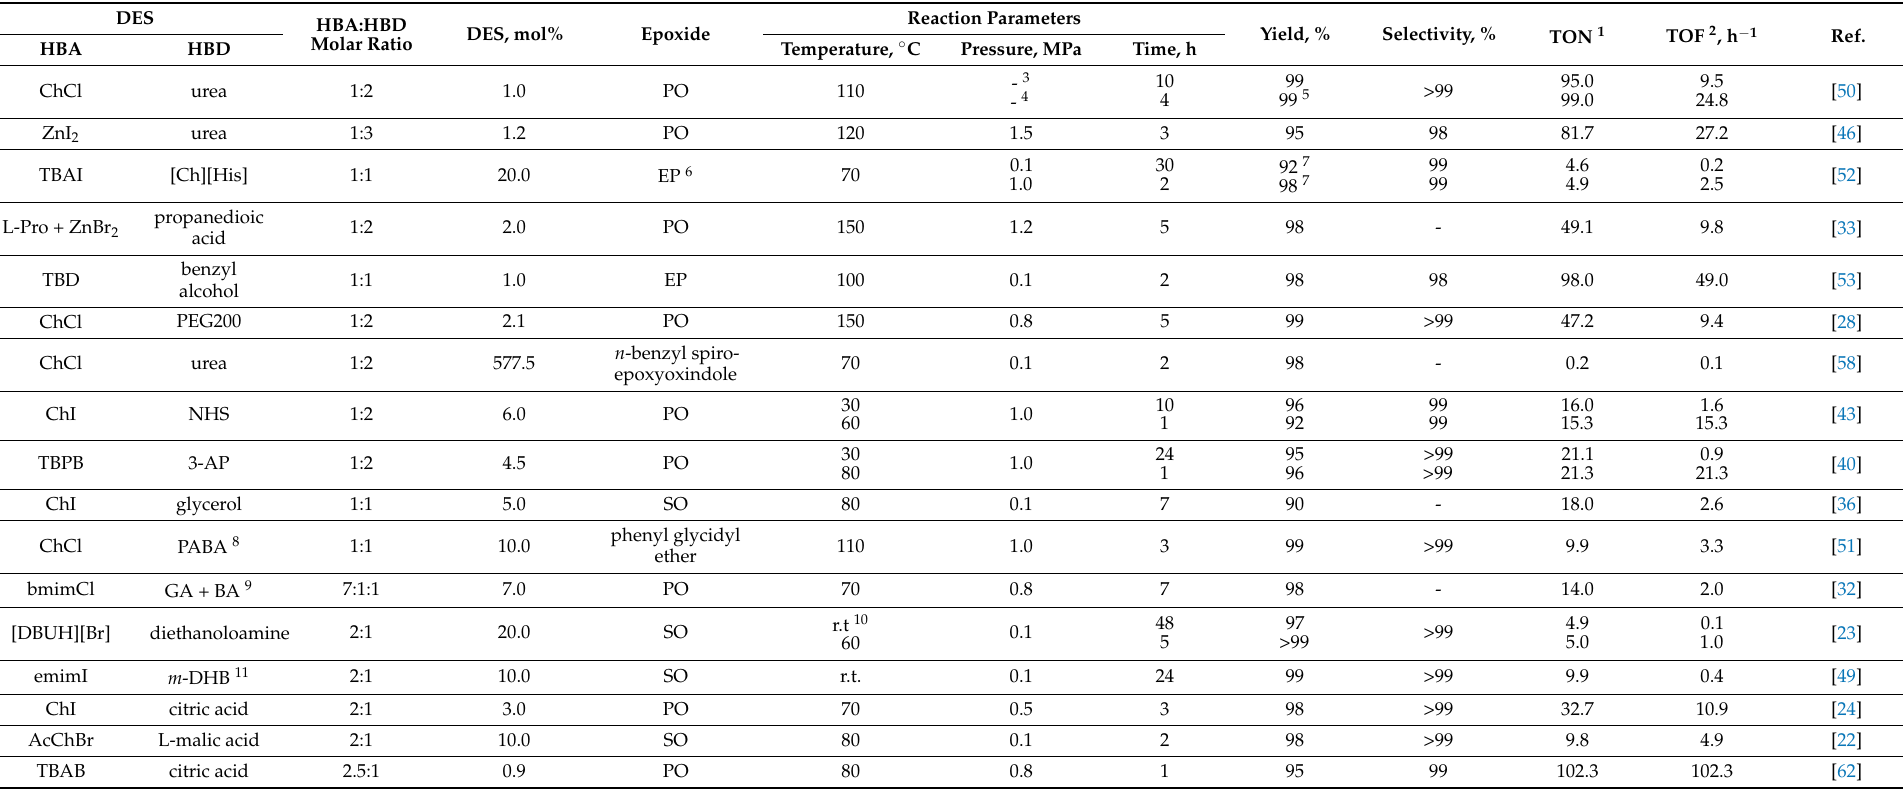
Table 1. Comparison of the results of cyclic carbonate synthesis with various DES-based